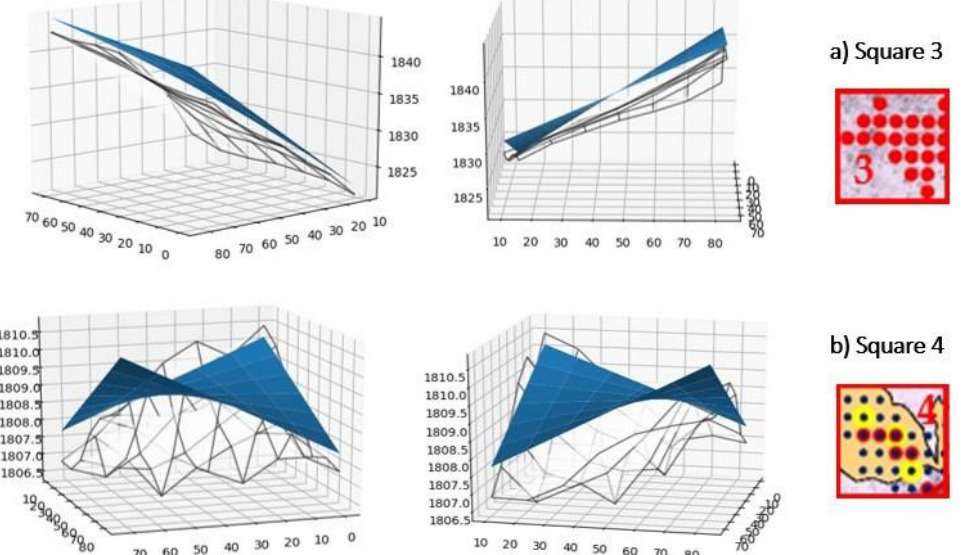
Figure 15. SMPF results for Square 3 ( a ) and Square 4 ( b ) from different perspectives. The blue surface represents the adjusted bilinear surface and the wireframe representation is the actual terrain.